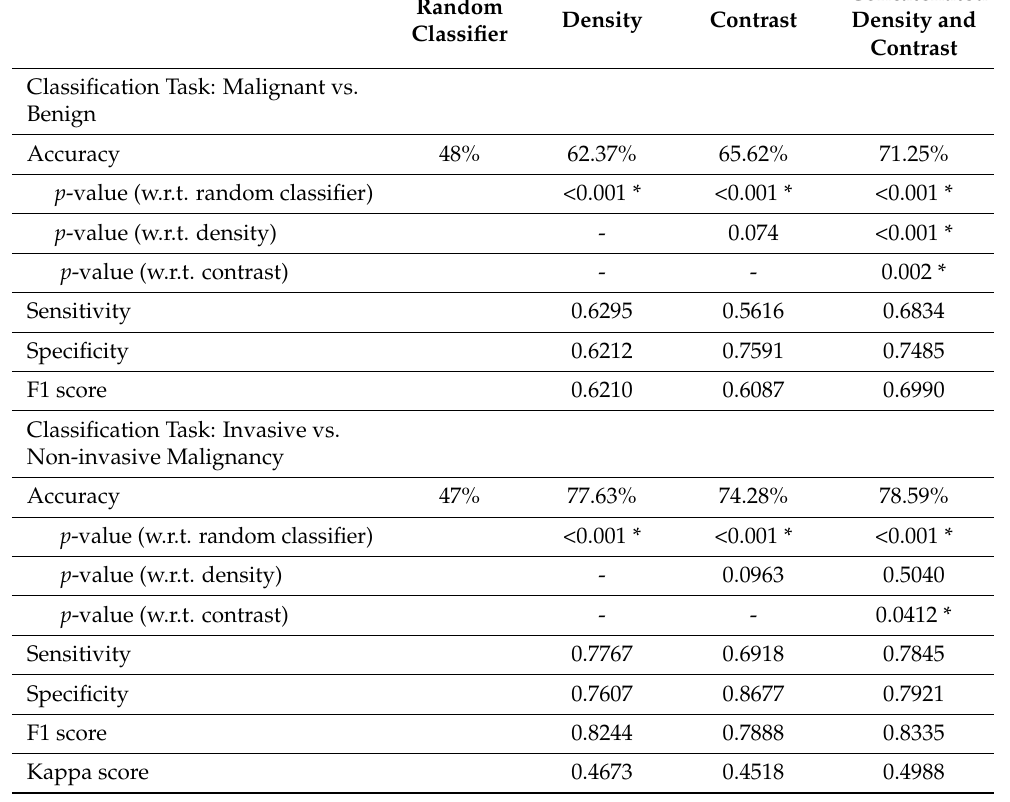
images and ( b ) contrast images, malignant lesions demonstrated a higher concentration of mammo- graphic density and intravenous contrast near the center of mass than benign lesions. Table 2. Classification performance of models utilizing radial histogram PLDA for density images, contrast images, and concatenated density and contrast images. W.r.t.: with respect to; * statistically significant ( p ≤ 0.05).